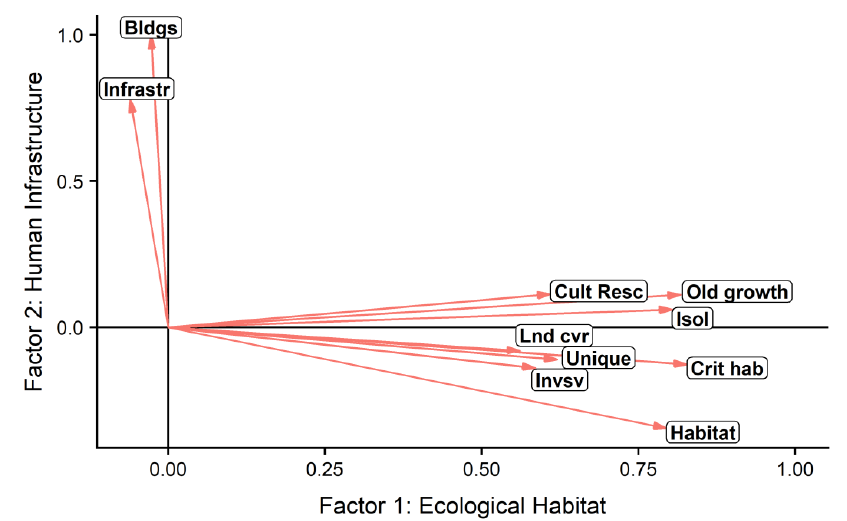
Figure 2. Factor loadings for each variable. Latent variables can be approximated by identifying the distribution patterns of observed variables along each axis. See Table A1 for descriptions of the abbreviations of the variables. Fire 2019 , 2 , x FOR PEER REVIEW Table 1. Multivariate analysis of variance (MANOVA) test for differences on response scores between demographic groups. df 1 and df 2 are the degrees of freedom, Pillai is the Pillai’s trace test statistic, F is the F -statistic, and p is the p -value.